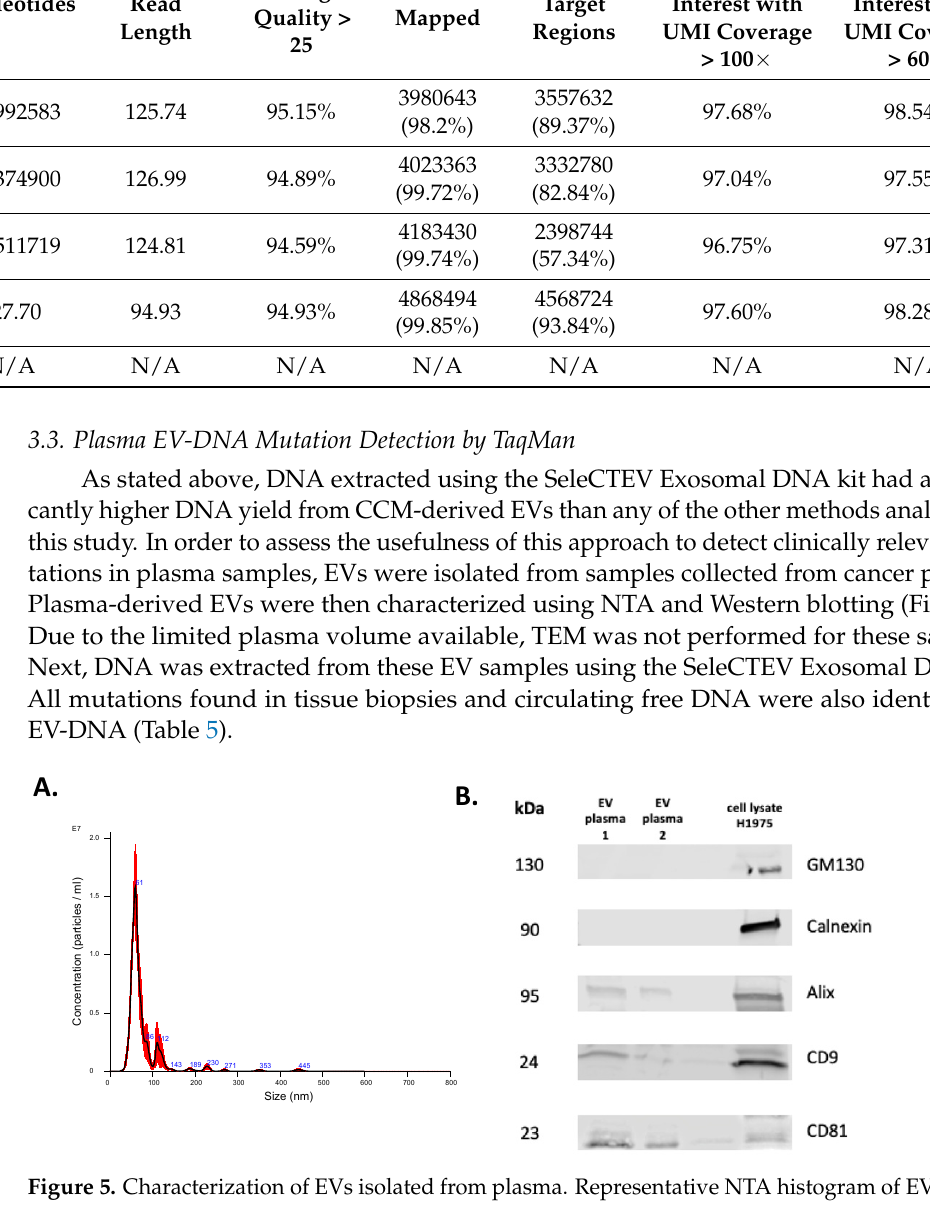
Figure 5. Characterization of EVs isolated from plasma. Representative NTA histogram of EV sample ( A ) and representative Western blots ( B ) of EV markers CD9, CD81, and Alix and of non-EV markers Calnexin and GM130 (H1975 cell lysate was used as a control).